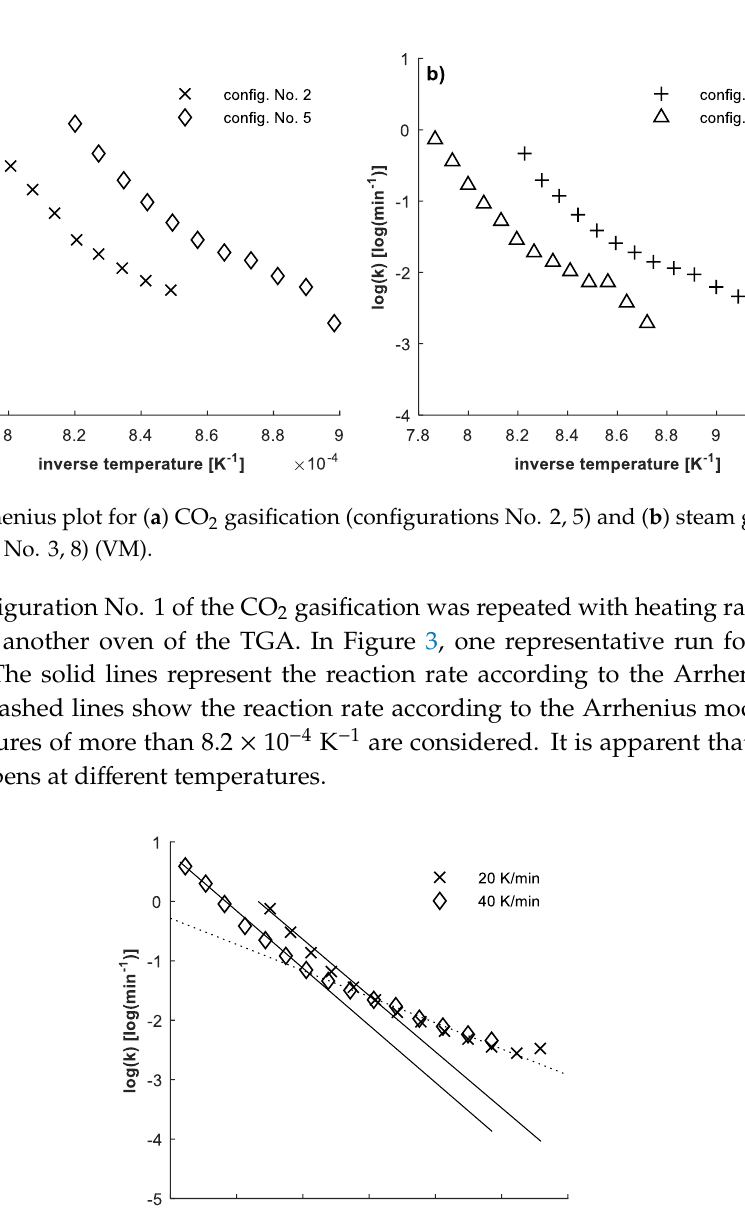
Figure 2. Arrhenius plot for ( a ) CO₂ gasification (configurations No. 2, 5) and ( b ) steam gasification (configuration No. 3, 8) (VM).